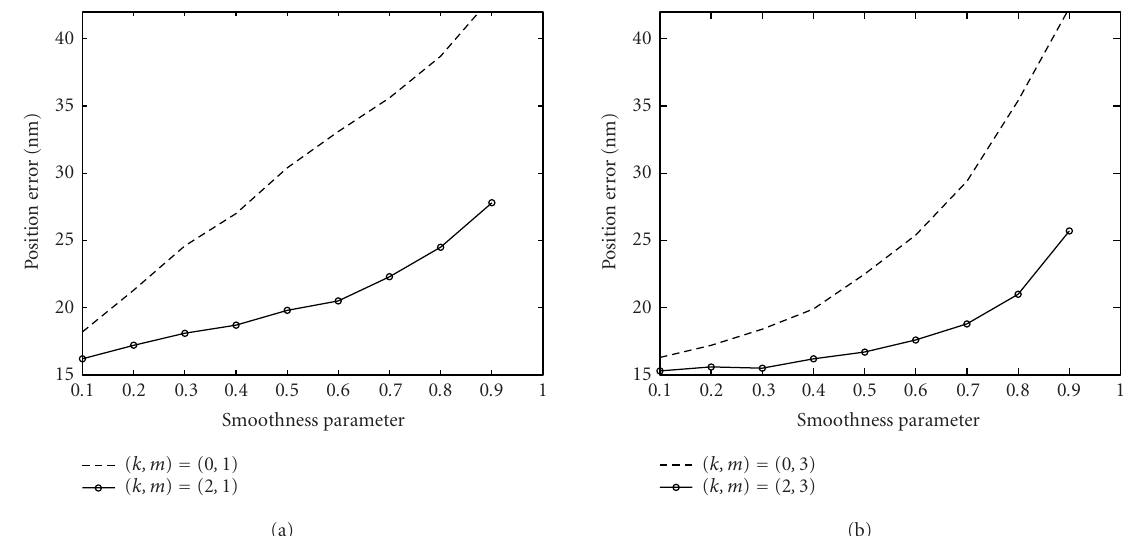
Figure 11: Position error for spline envelope with noisy data: (a) ( k , m ) = (0,1), ( k , m ) = (2,1) and (b) ( k , m ) = (0,3), ( k , m ) = (2,3).